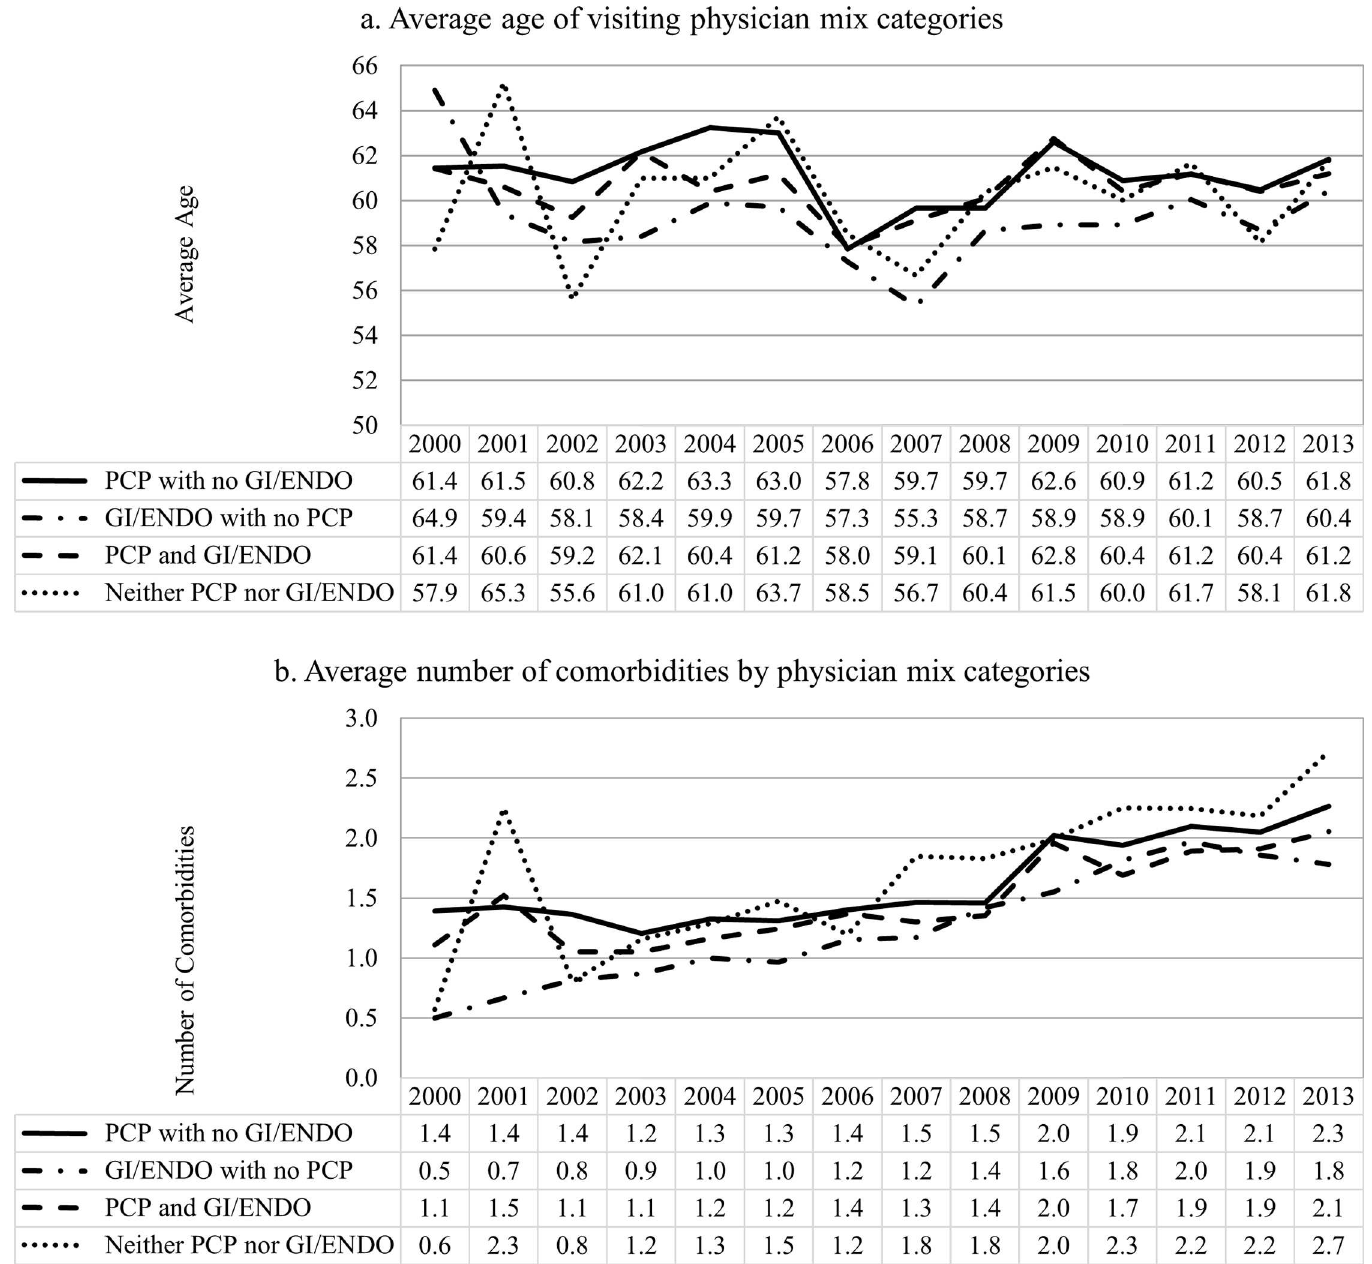
Fig 4. Average age and number of comorbidities by physician mix categories by